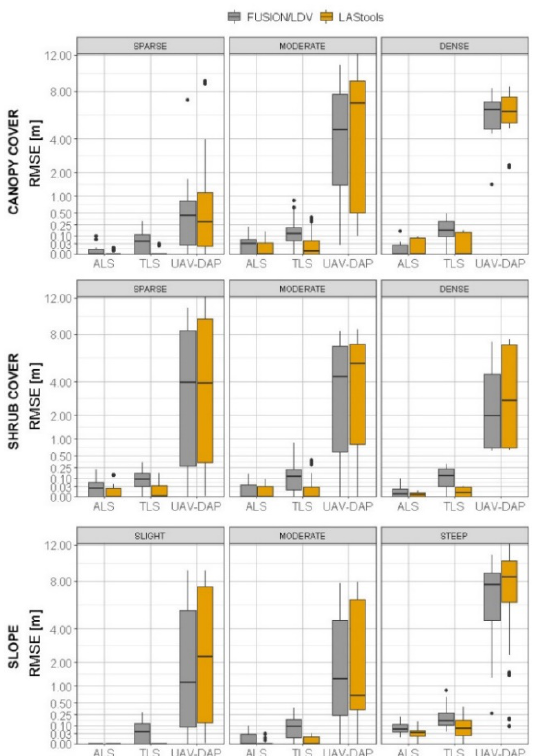
Figure 7. Box and whiskers plot representing the RMSE between the DTMs extracted from the acquisition techniques (i.e., ALS, TLS and UAV-DAP) and the reference DTM, using different processing tools (i.e., FUSION/LDV© and LAStools©), different algorithm parameters and grouped by different categories of canopy, shrub cover and slope